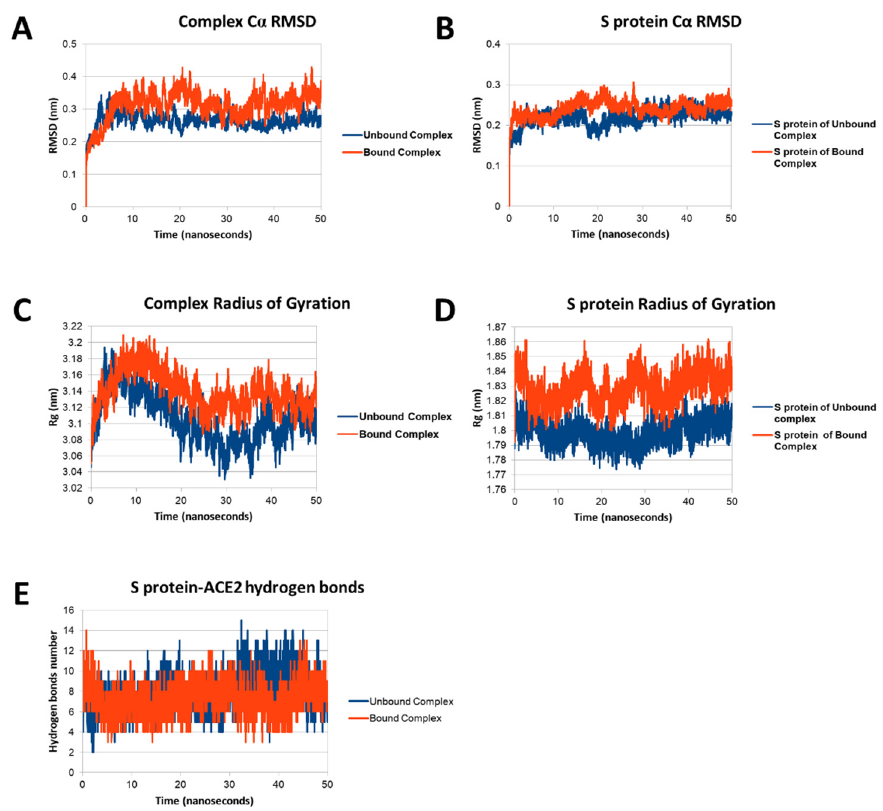
Figure 5. Molecular dynamic of SARS-CoV-1 S protein–ACE2 complex in the unbound state or bound to emodin. ( A ) RMSD plot of complex C α . ( B ) RMSD plot of S protein C α . ( C ) Plot of complex’s radius of gyration. ( D ) Plot of S protein’s radius of gyration. ( E ) Hydrogen bonds plot.